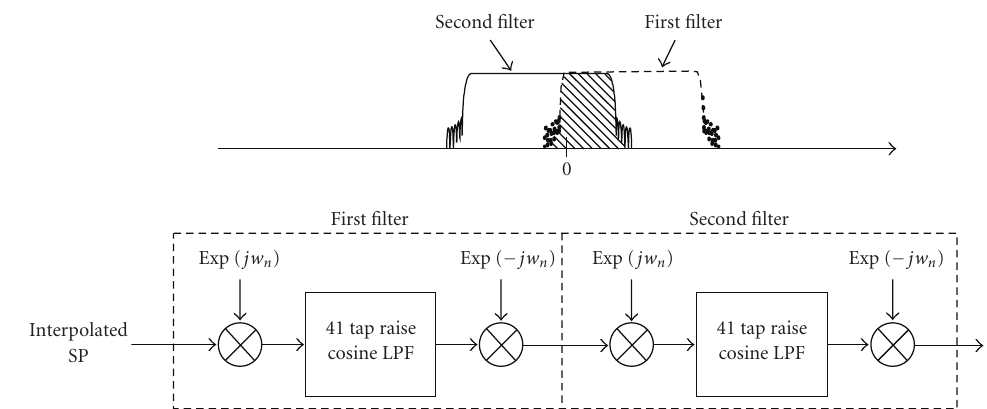
Figure 10: Variable bandwidth super denoise filter.